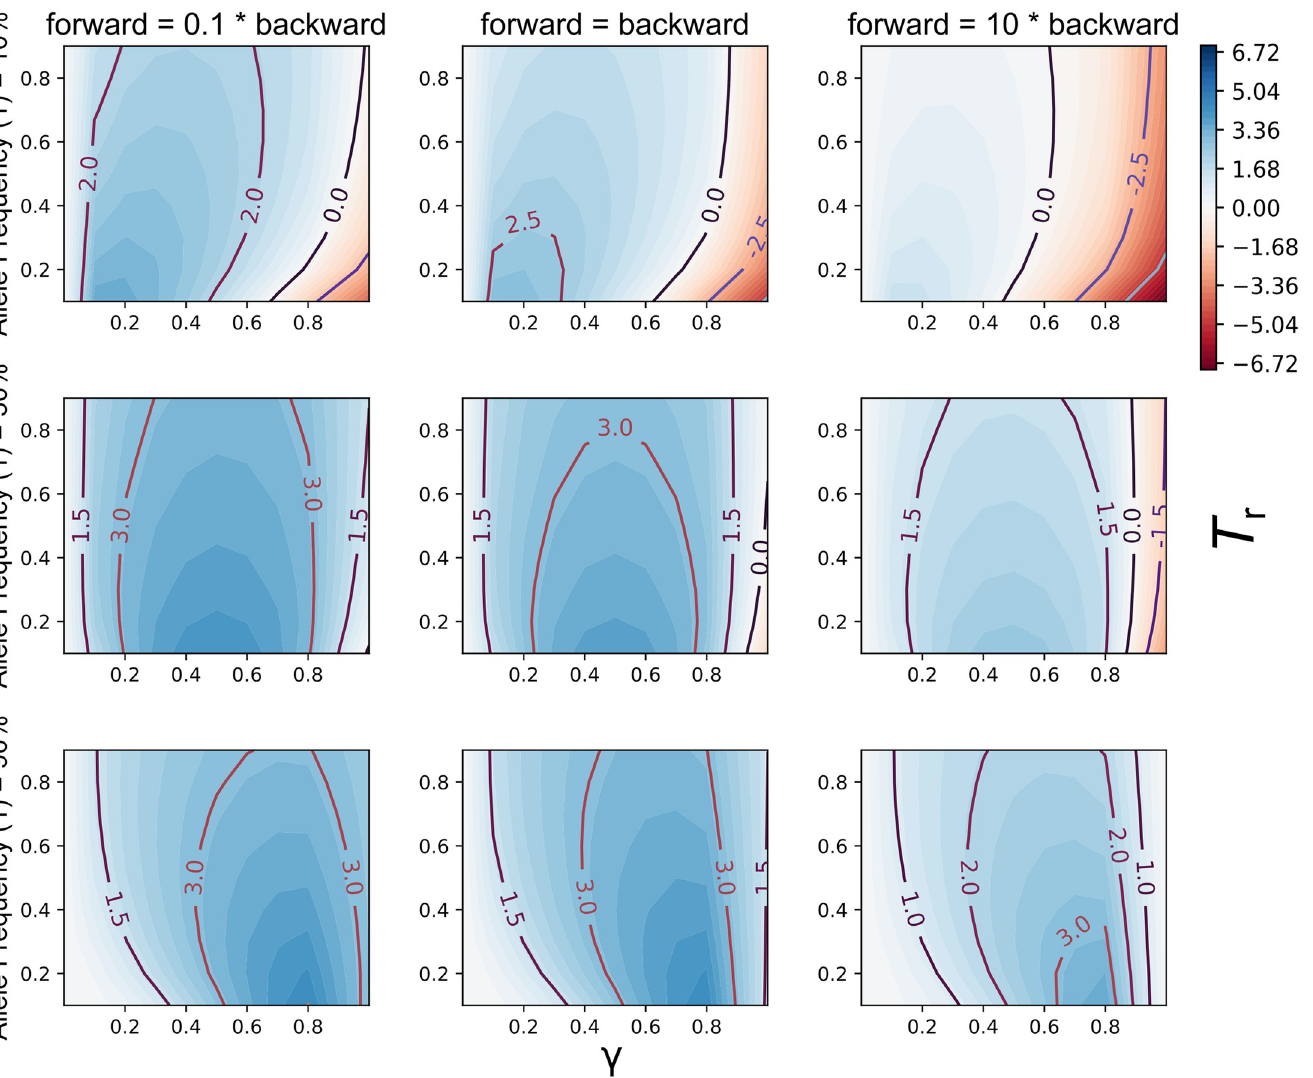
Fig 4. G-XRF values in the presence of trait polymorphism. The x- and y-axis in each panel correspond to the inheritance probability γ and reticulation time T respectively. Columns correspond to three different relative forward/backward character substitution rates, and rows correspond to three different frequencies of all 1 in taxon B. In all panels T 2 − T 1 = 10 coalescent units and θ =